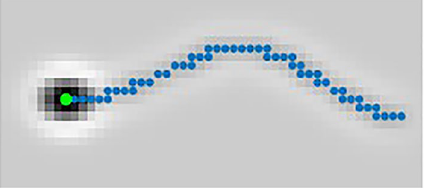
Figure 4. Simulated sperm image with points for the location of the head (green) and the curve of the flagellum (blue).